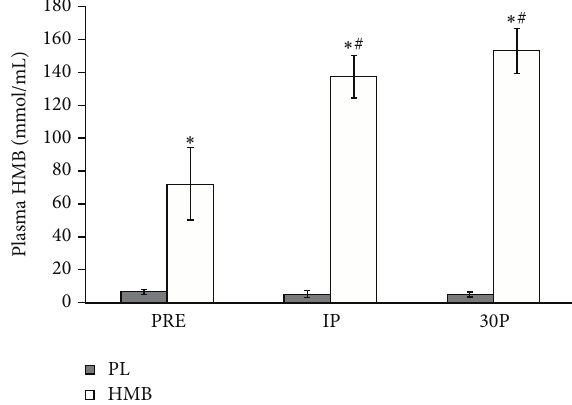
Figure 1: Plasma HMB concentration values for PL, HMB-FA, and time points at PRE, IP, and 30P. HMB was administered 15 min PRE blood draw. ∗ Significantly elevated from PL and HMB-FA ( 𝑃 < 0.01 ); # significantly elevated from PRE ( 𝑃 < 0.01